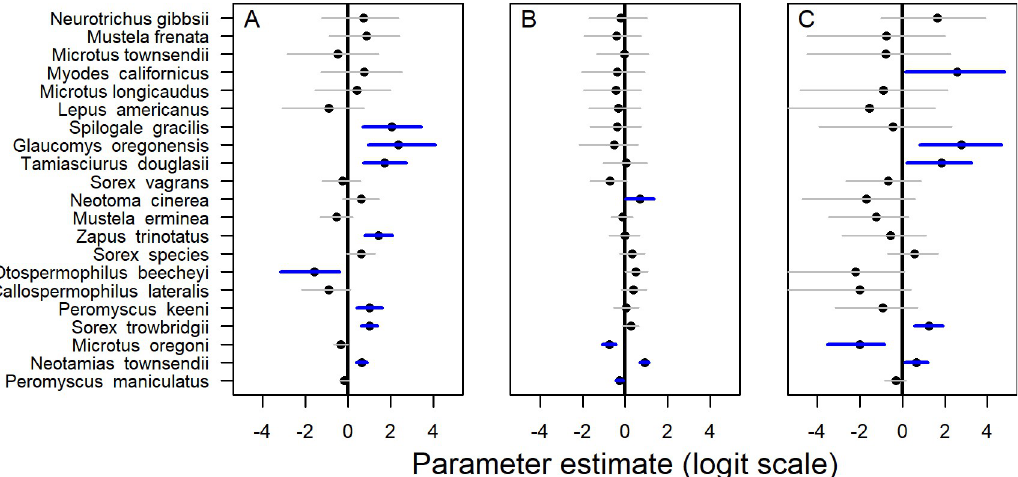
Fig 5. Coefficient estimates (points) and 95% Bayesian credible intervals (horizontal lines) for effects of three subplot types, (a) riparian patches, (b) upland patches, and (c) rotation-aged forests, on occupancy of 21 small mammal species compared to clearcut subplots. 95% credible intervals that do not include zero (black line) are indicated in blue. Estimates are from a community occupancy model with a sample size of 59 stands and 209 subplots within stands, sampled over three years, 2017– 2019, northwest Oregon and southwest Washington,